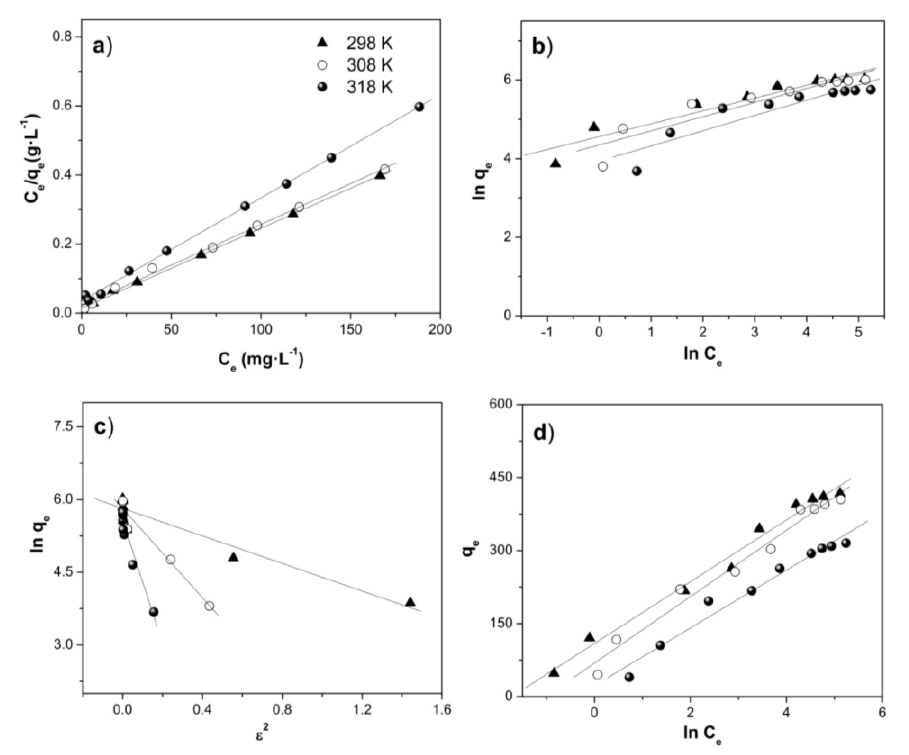
Figure 5. Adsorption isotherm models for Orange II dye adsorption over Fe(BTC): ( a ) Langmuir isotherm; ( b ) Freundlich isotherm; ( c ) D-R isotherm and ( d ) Tempkin